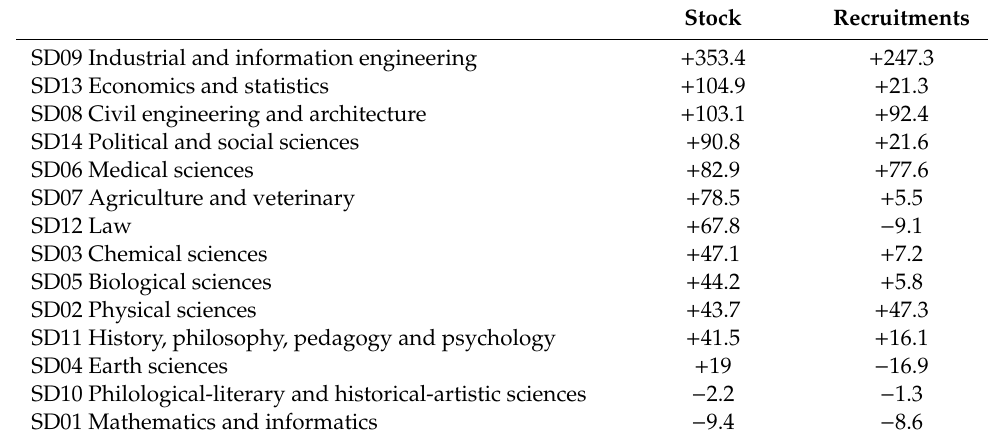
Table 4. Female % variation by scientific fields 2000–2018, stock and recruited.